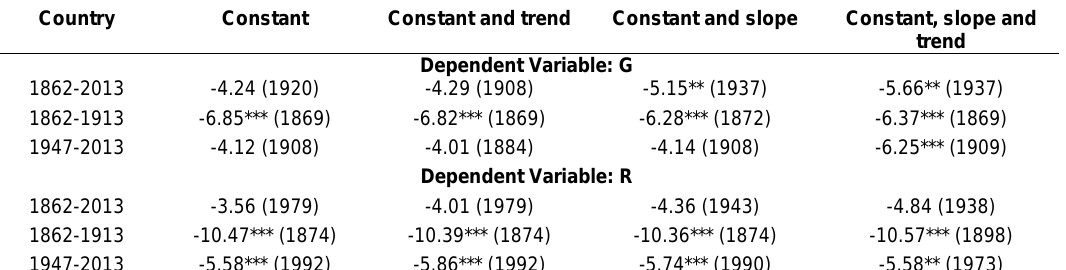
Table 5. Gregory and Hansen cointegration tests.